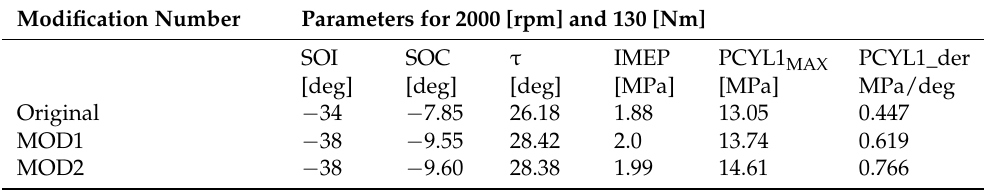
Figure 8. The waveform of the main injection and combustion parameters (Original maps), i.e., the rate of heat of combustion (Q1), the amount of heat of combustion (L1), the combustion pressure (PCYL1), the rate of combustion pressure buildup (PCYL1_der) and the injector control signal (INJ_SIG1)—under established engine operating conditions, engine speed 2000 [rpm] and load 130 [Nm]. Table 4. Parameters for 2000RPM and 130Nm.